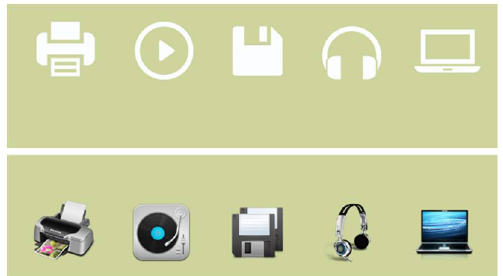
Figure 4. Screens displayed to users in Step 4 (click on the icon for customer support).